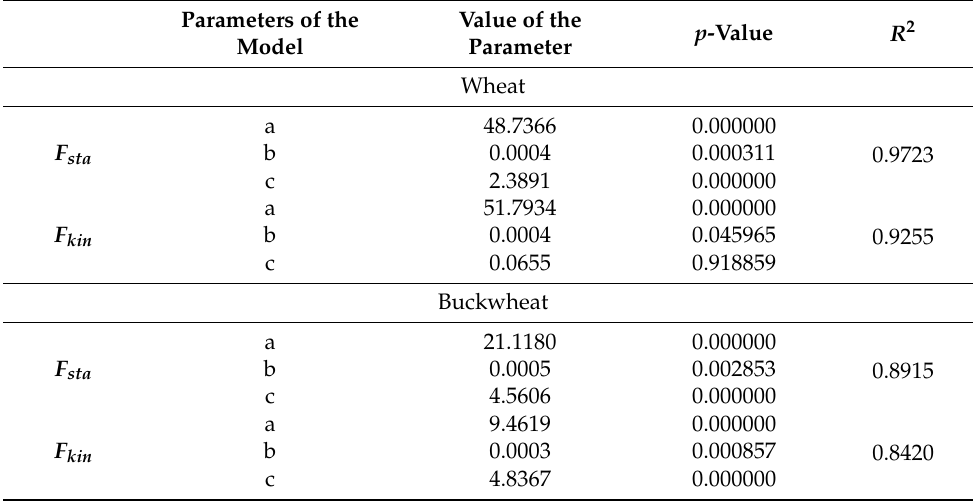
Table 4. Values of regression parameters for particular model